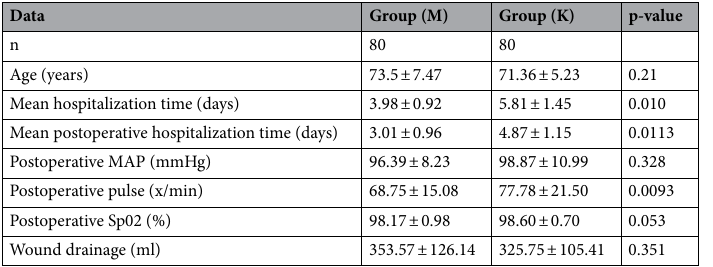
Table 1. General data describing the analyzed elderly patients (over 65 years old) divided into the study group (M) and the controls (K). MAP mean arterial pressure.